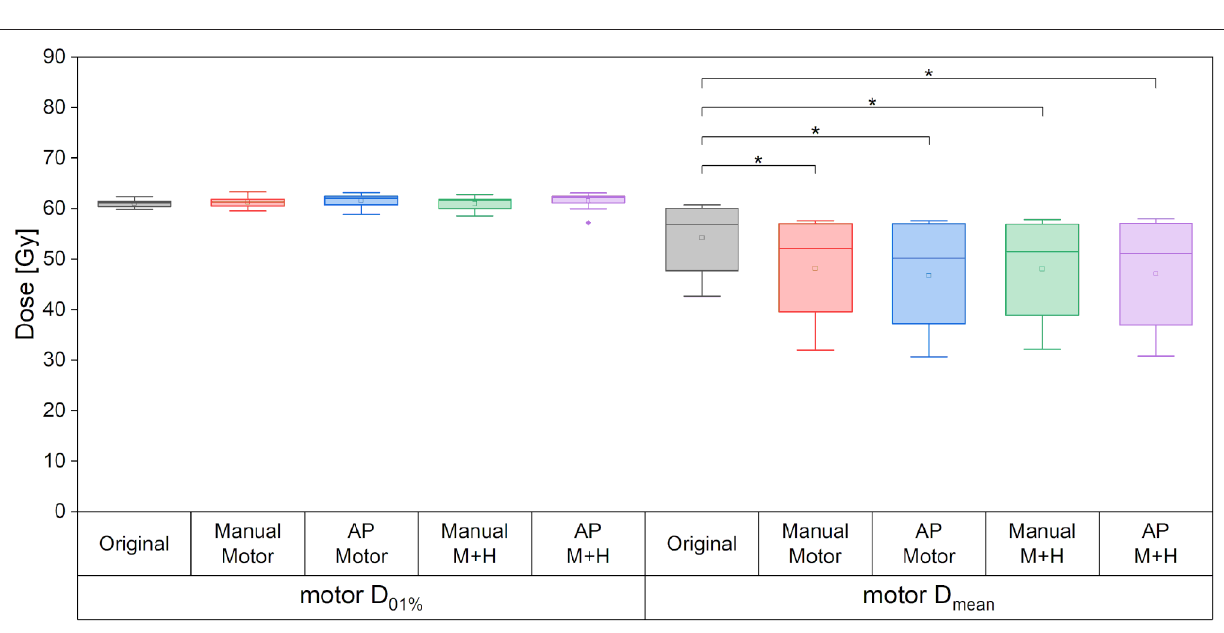
Frontiers in Neurology |